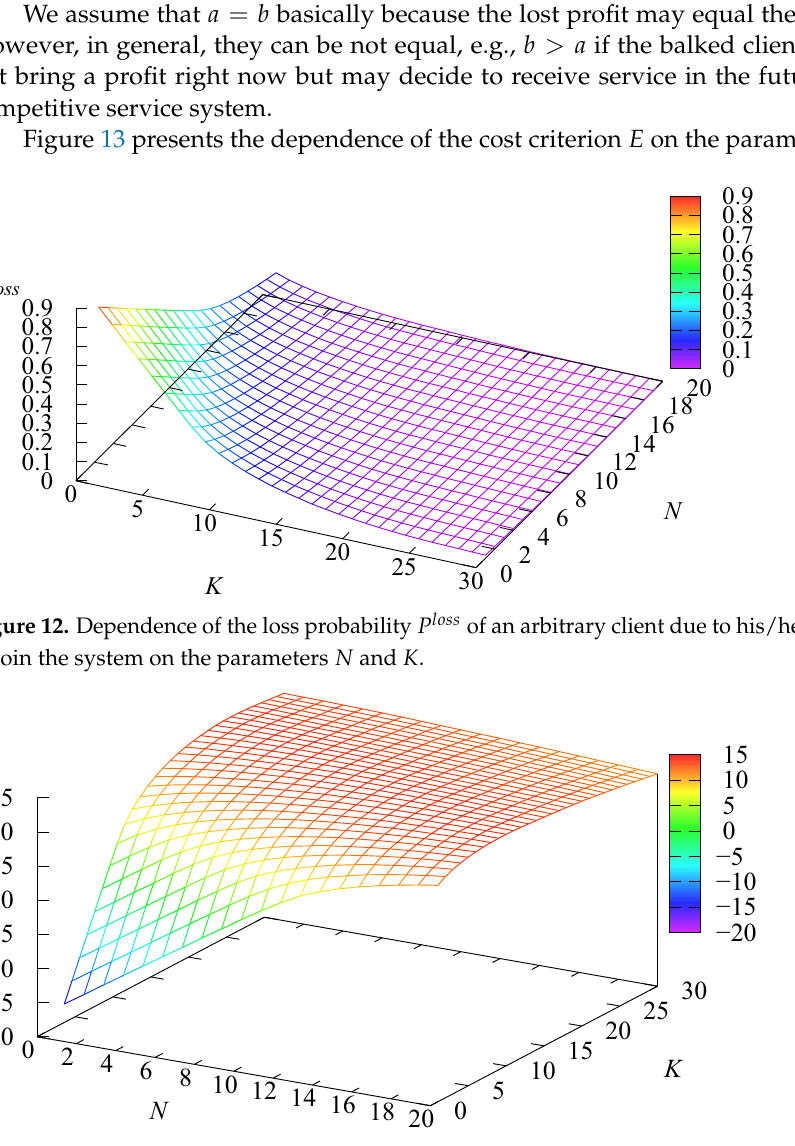
Figure 13. Dependence of values of the cost criterion E on the parameters N and K